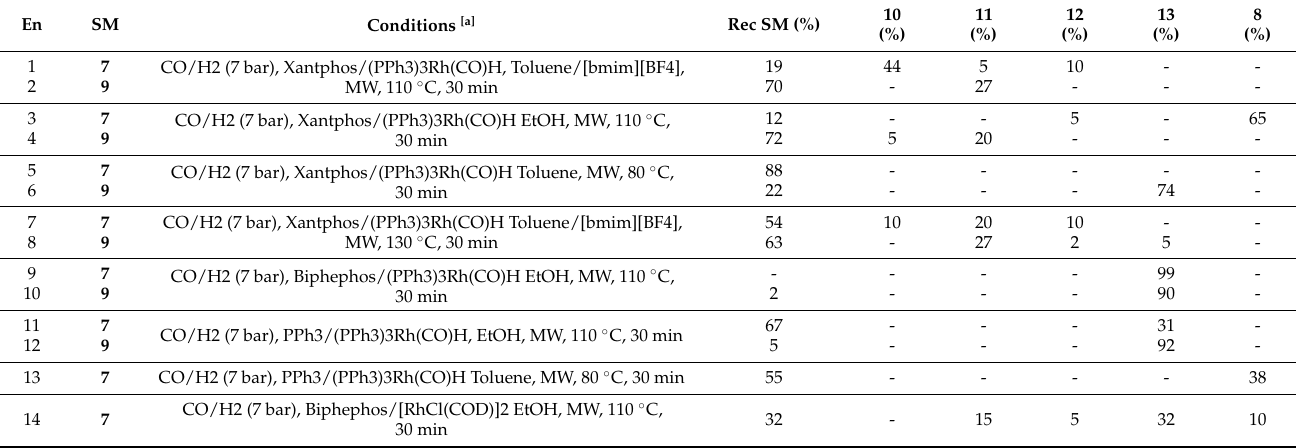
Table 1. HAM optimisation for the synthesis of